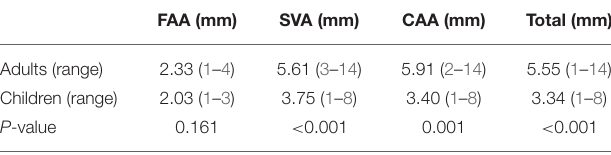
TABLE 4 | Diameter of adults and children in different